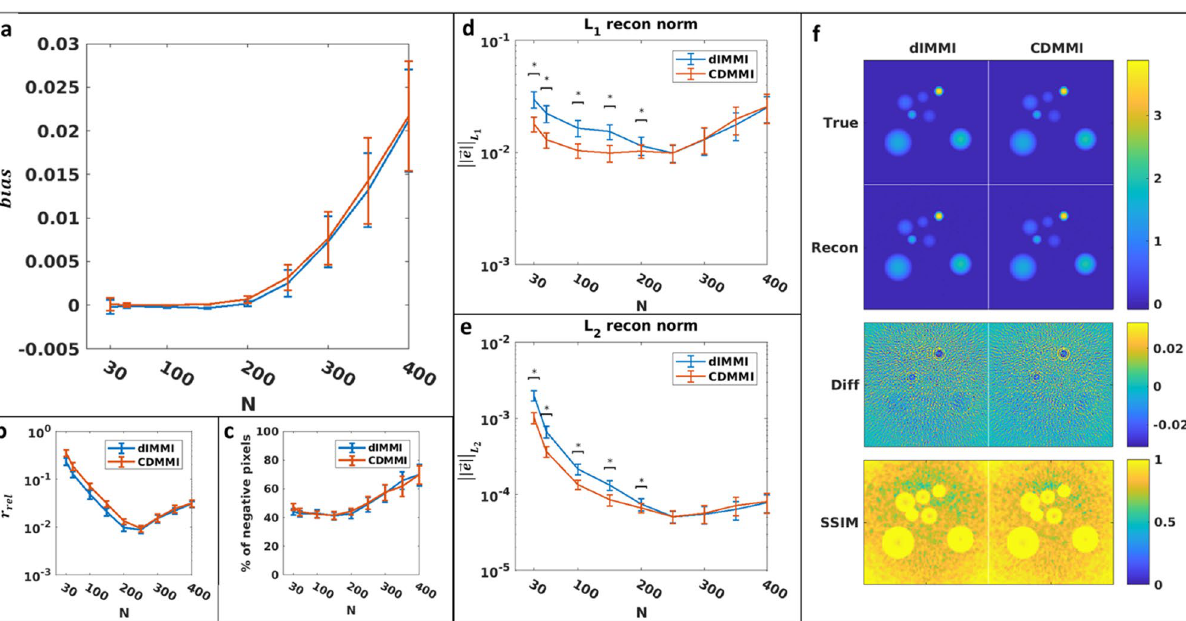
Figure 4. Comparison of dIMMI- and CDMMI-based reconstructions using the LSQR reconstruction algorithm. ( a ) Both models have a tendency towards increasing absolute error as a function of image size, though ( b ) the relative residual for CDMMI is higher than dIMMI for low image resolutions, converging at higher resolutions. ( c ) Both models incur similar numbers of negative pixels in their reconstructions. These trends are reversed, however, when considering the reconstruction L 1 norm ( d ) and L 2 norm ( e ) for each model, with CDMMI outperforming dIMMI when reconstructing at low resolutions; again, both methods perform similarly at high resolutions. ( f ) depicts the ground truth, reconstructed, difference, and SSIM images for each of the methods. Both methods appear to perform similarly well, and the introduction of reconstruction artifacts as seen in the SSIM images affects both to comparable degrees. Figure created using a combination of MATLAB and Microsoft variation in the various error metrics shown in Figs. 4 and 5—LSQR internally uses a more numerically stable algorithm and converges more efficiently than the fundamentally nonlinear nnAPCG method. Together with convergence, a similar question applies to analytical quality; although the absolute error of a given reconstruc- tion may be low in a numerical or simulated environment, artifacts may appear in real data due to nonlinearities and modelling inaccuracies, which are not fully captured by the forward models. LSQR, despite its favorable numerical properties, provides no guarantees of converging to a sensible value, and due to the non-local nature of the photoacoustic imaging equations, errors or nonphysical values in one pixel will affect the reliability of values in other pixels. Due to this combination of factors, we recommend the use of the nnAPCG method when possible, as it provides an inherently constrained reconstruction suitable for use in further analyses, particularly regarding spectral unmixing. Indeed, the use of a non-negative analysis constrains the possible SO 2MSOT values